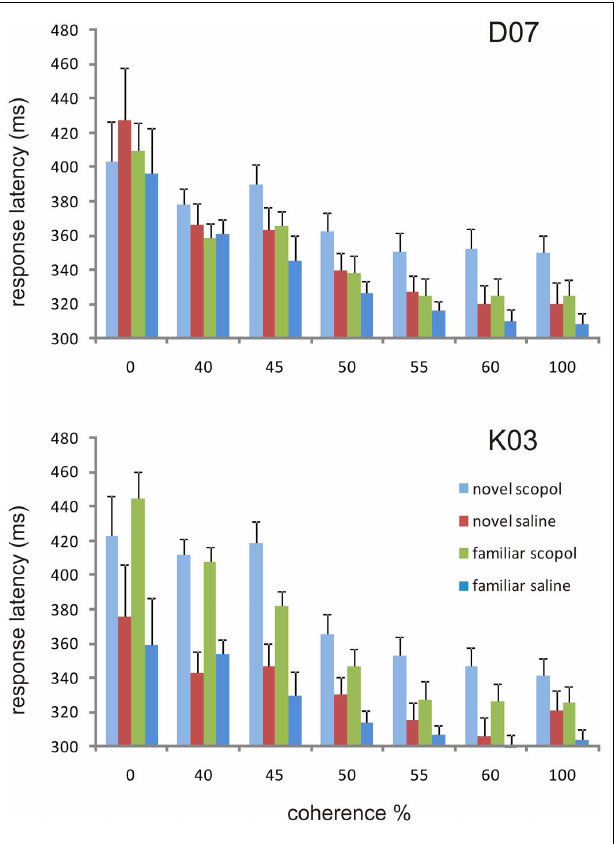
FIGURE 6 | Response latencies under the four different conditions at the seven different coherence levels. Response is measured from the time the stimulus is presented to the time the appropriate lever is released and is shown here for the correct responses only. In monkey D07 (scopolamine drug injections 7.5 and 10 μ g/kg combined), response latencies were shorter for the more coherent stimulus levels